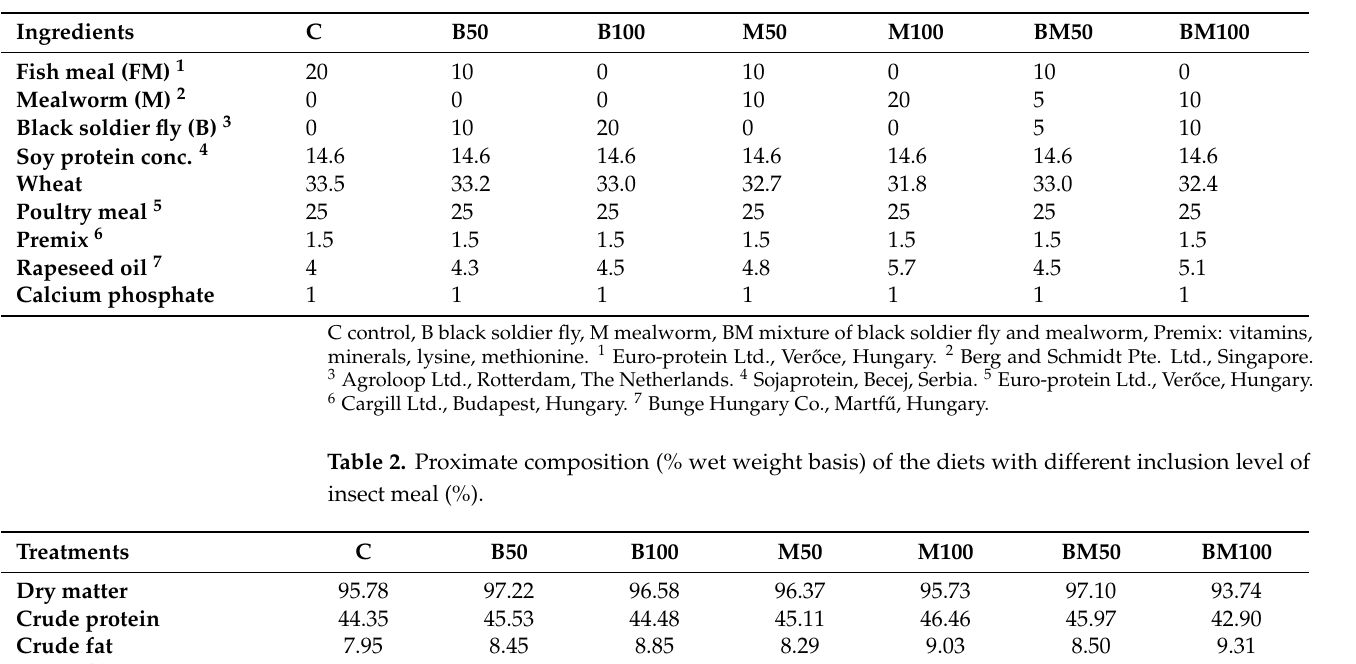
Figure 1. Schematic diagram of the experimental setup and the measured parameters at the end of the trial. Table 1. Formulation of the diets with different inclusion level of insect meal (%).